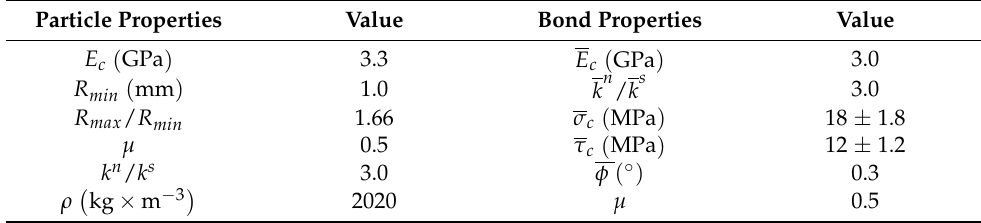
Table 2. Microparameters of linear parallel bond model